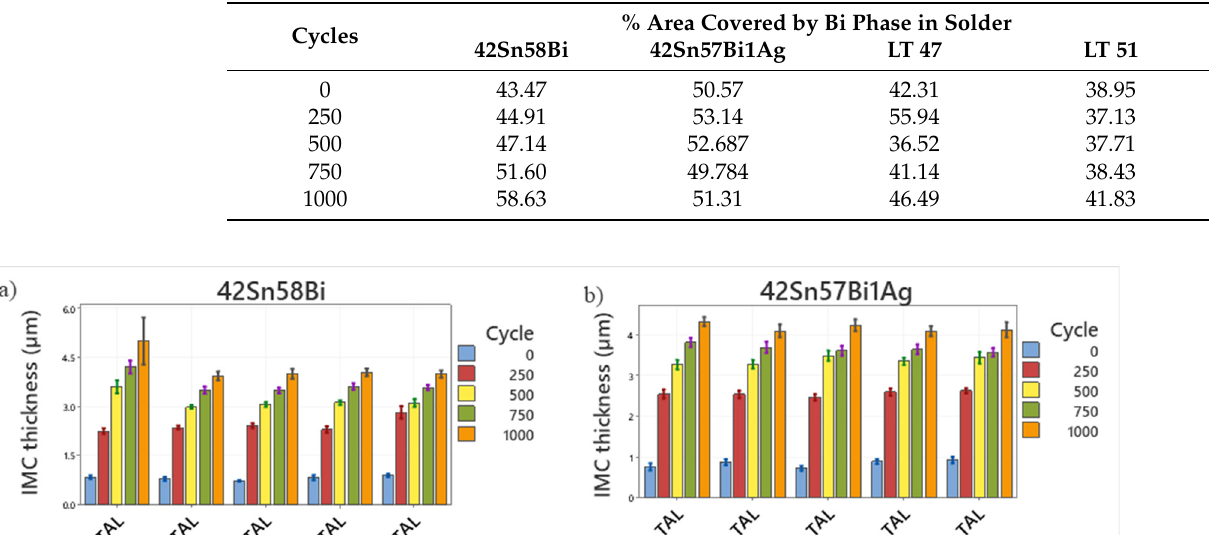
Table 4. % Area covered by Bi phases during each stage of thermal cycling.